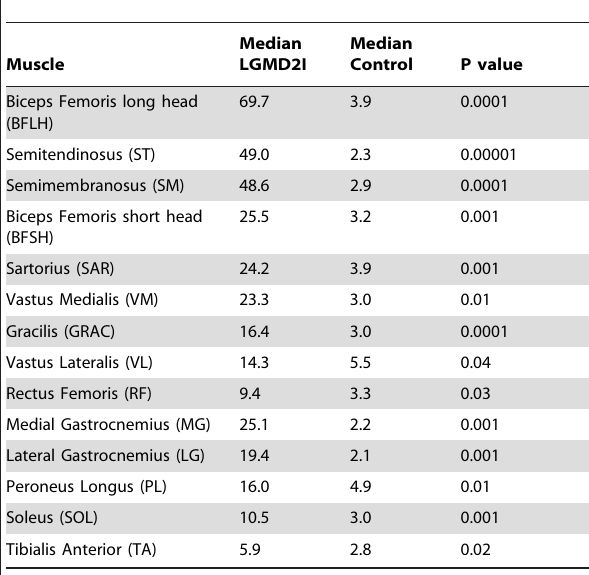
Table 3. The median values of fat fraction (%) in the patient group and the control